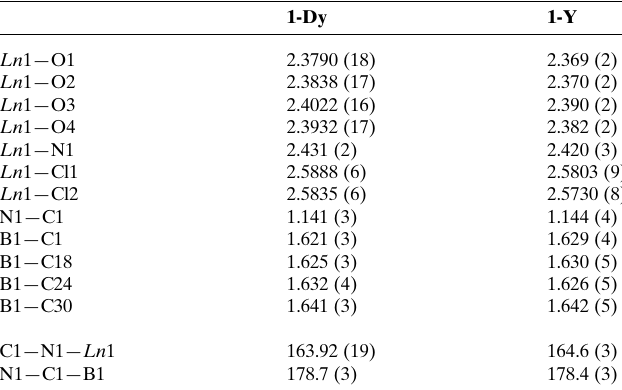
Table 1 Selected bond lengths and angles (A˚ , (cid:4) ) for 1-Dy and 1-Y